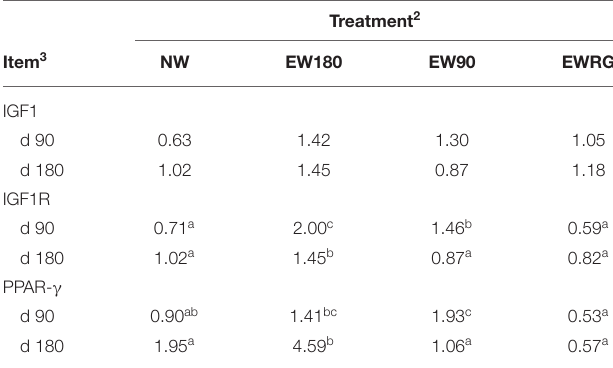
TABLE 1 | Muscle mRNA expression of genes associated with growth and adipose tissue development in beef steers developed in different calf management systems from the time of early weaning (d 0) 1